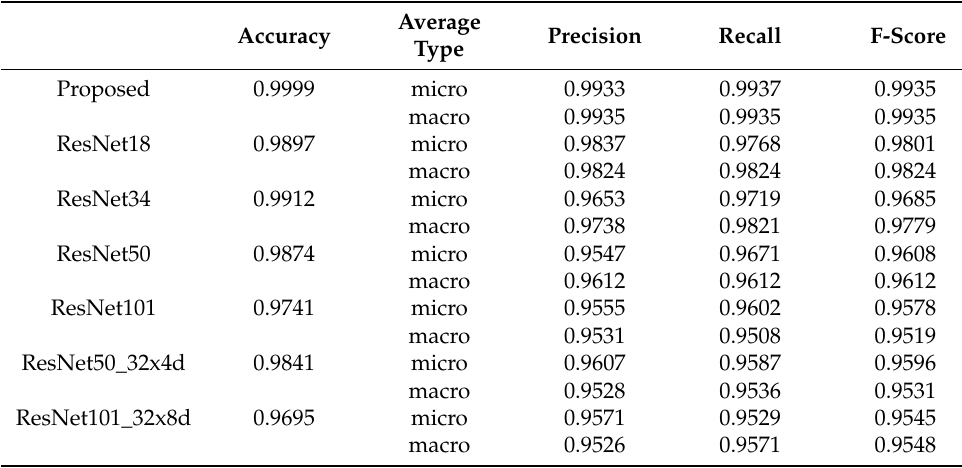
Figure 10. F-score of different grayscale images and multi-channel images. Table 5. Performance comparison of different ResNet neural